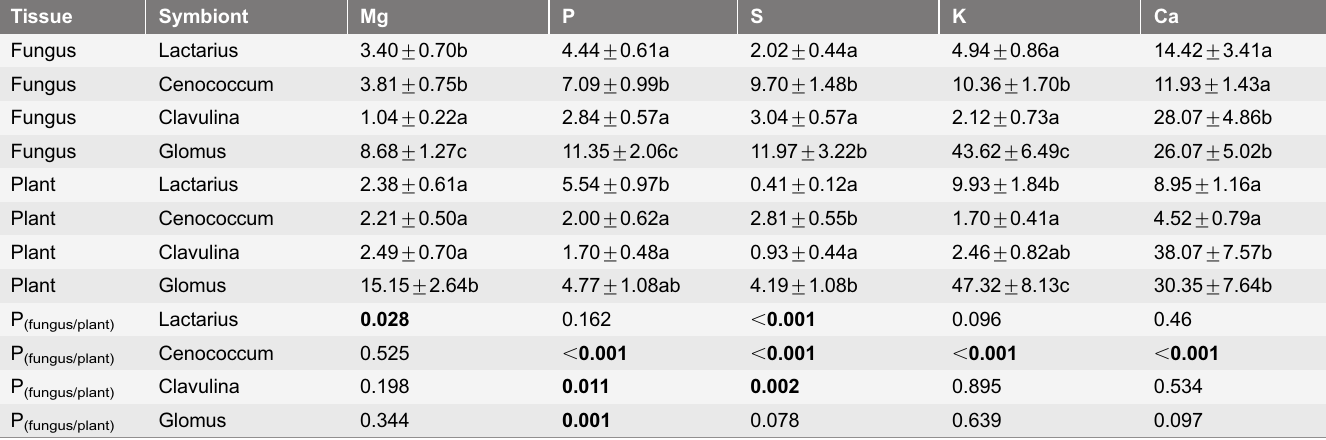
Table 1. Relative abundance of nutrient elements in plants and their associated fungal species.